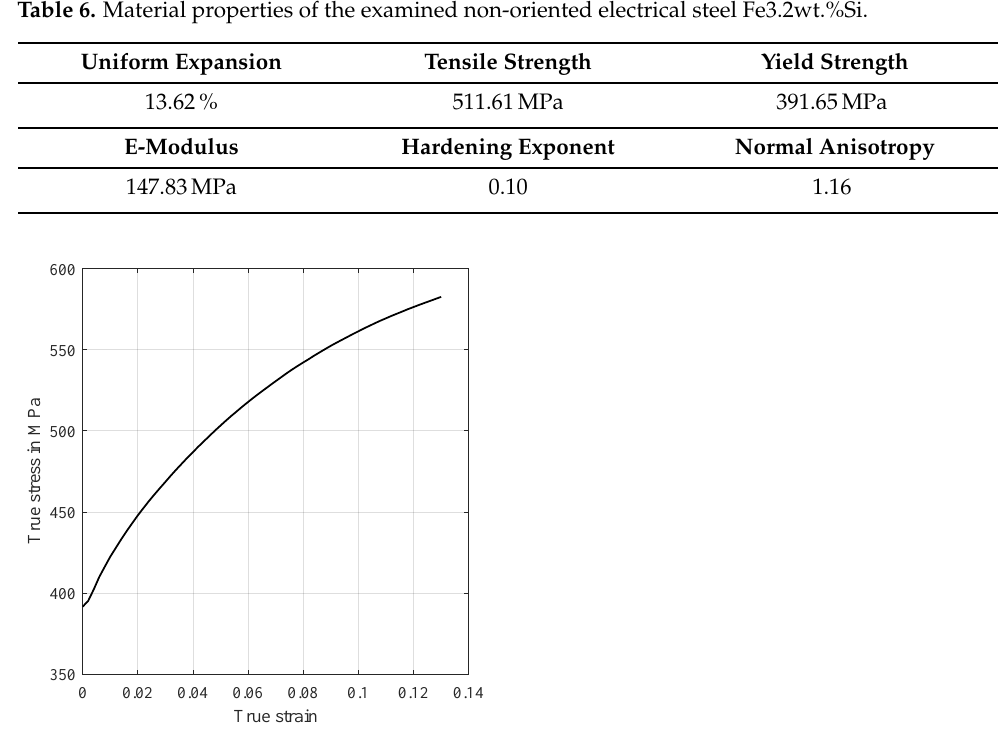
Figure 13. Experimental flow curve for the examined electrical